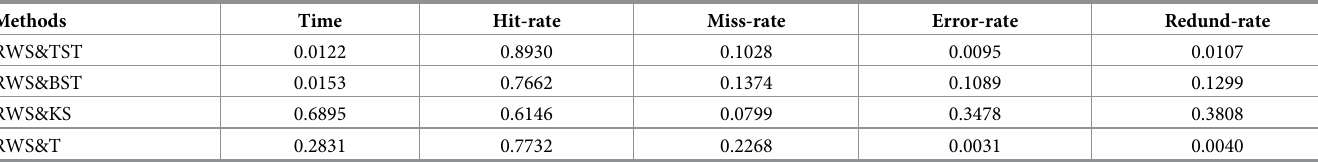
Table 1. The mean analyses on MCPs detection under different numbers of MCPs from 2^6 to 2^15 in the RWS framework. Methods